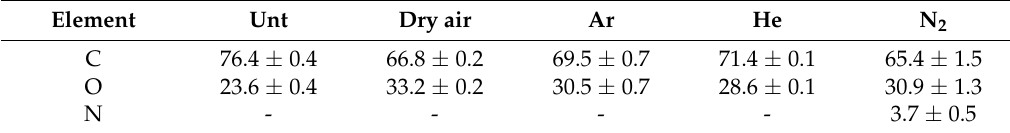
Figure 3. ( A ) Survey spectrum of N 2 plasma-treated PEOT/PBT; ( B ) example of a C1s deconvolution (N 2 plasma-treated sample); ( C ) example of an N1s deconvolution (N 2 plasma-treated sample); ( D ) C1s peak deconvolution results for the different treatments; ( E ) N1s deconvolution results of the N 2 plasma-treated surface. Table 2. Overview of the surface elemental composition (in at %) as measured by XPS survey scans of the different treatments (Ar: 11.3 J/cm 2 ; He: 22.6 J/cm 2 ; N2: 45.2 J/cm 2 and Dry air: 45.2 J/cm 2 ).